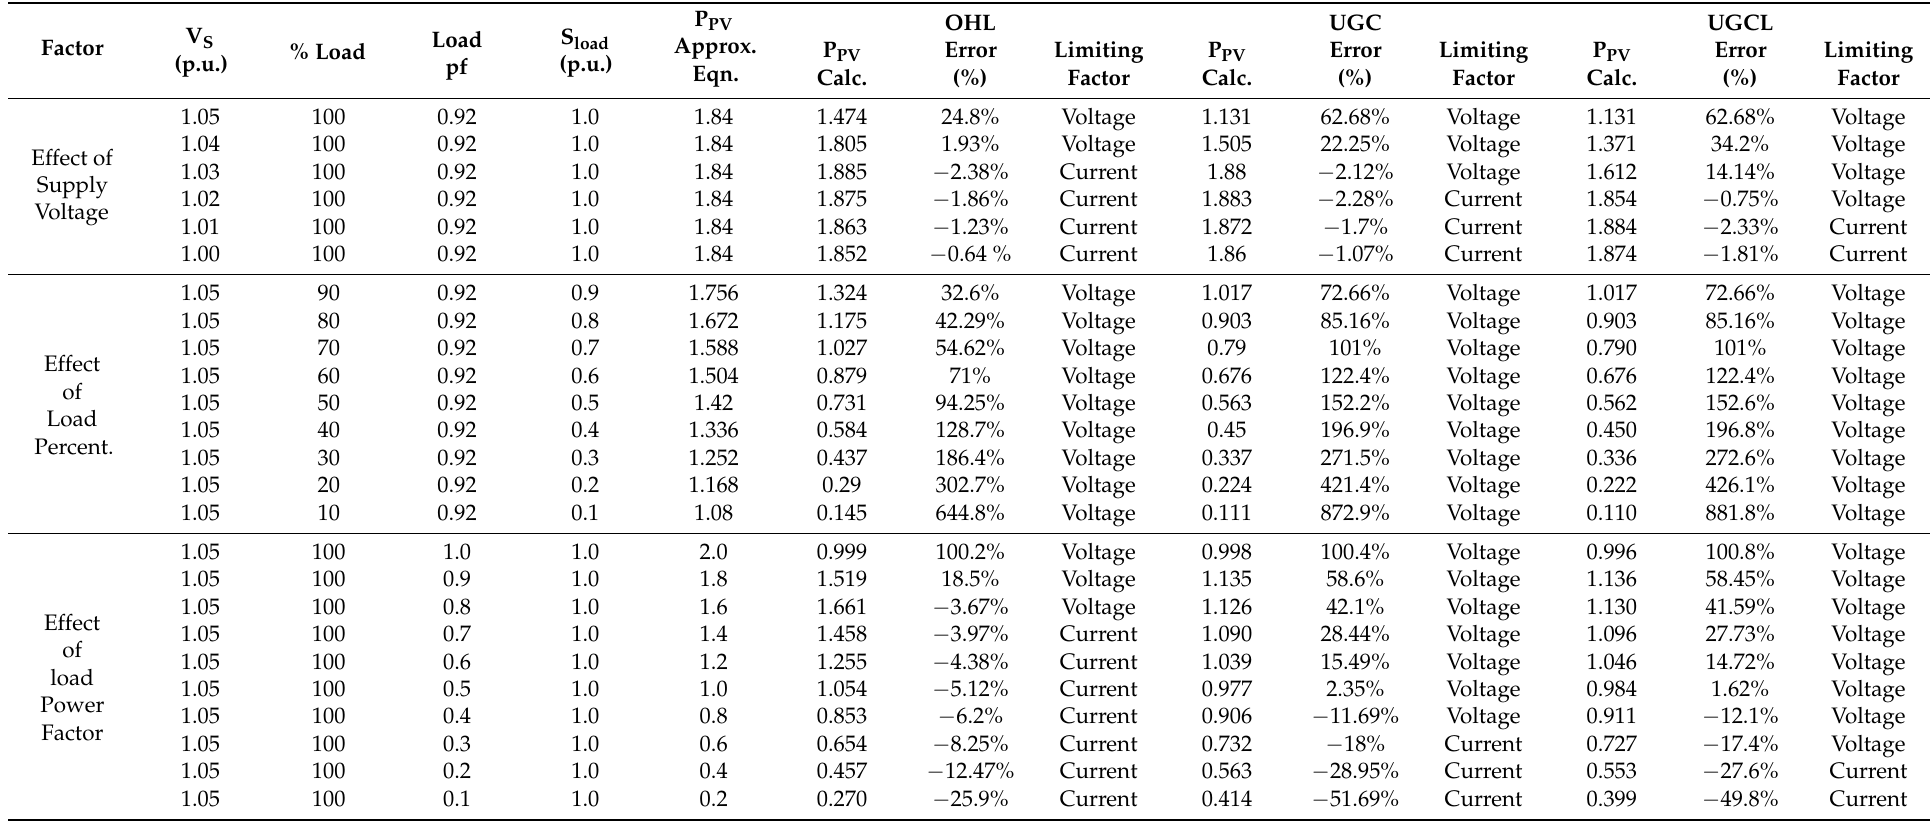
Table 10. Maximum PV penetration comparison between calculated values and approximate